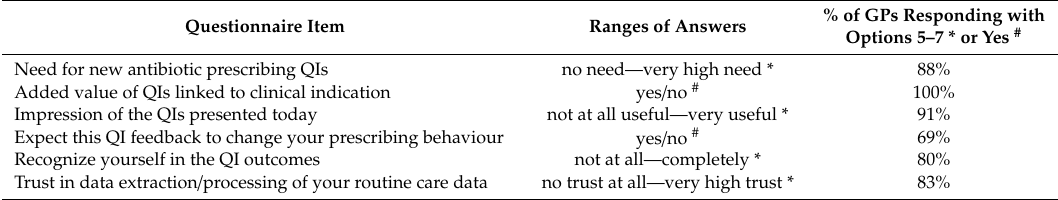
Table 3. General practitioners’ opinions of the new set of antibiotic prescribing quality